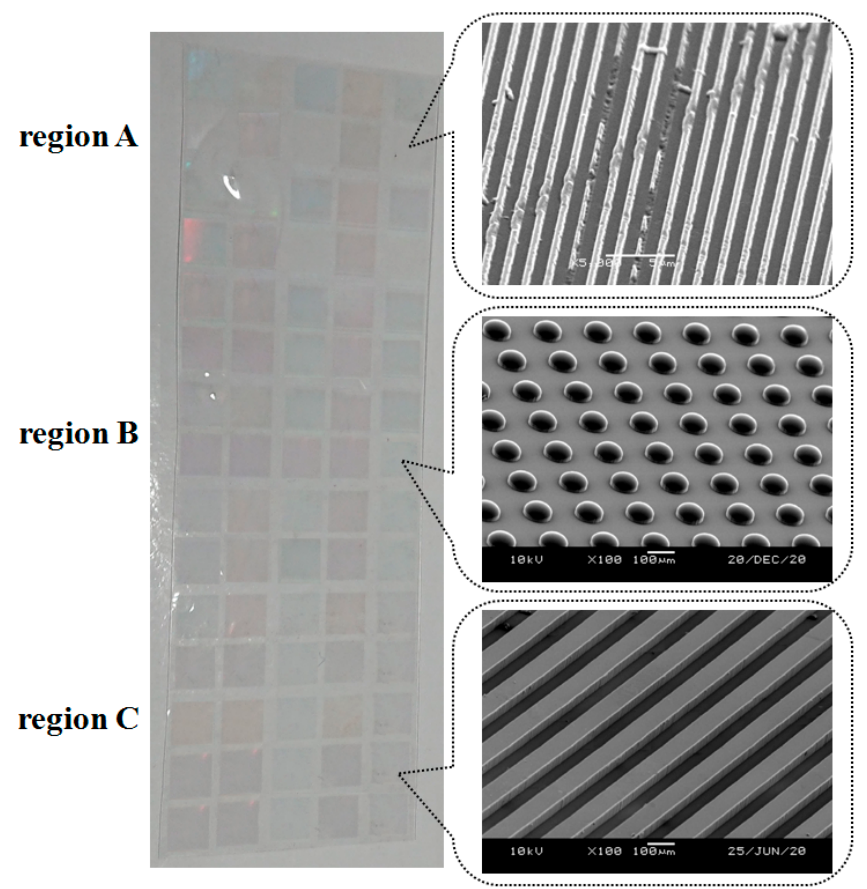
Figure 8. Preliminary experimental results of the traditional isothermal hot embossing process with multiscale microstructures. (When the embossing pressure and embossing time were maintained at 30 kg cm − 2 and 120 s, the practical embossing temperatures of zones A, B, and C were 169.5, 169.2, and 168.8 °C, respectively.)